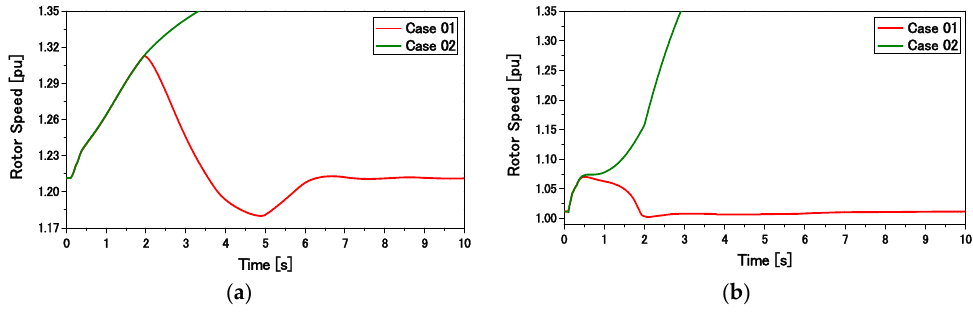
Figure 19. Rotor speed response of wind generators: ( a ) DFIG; ( b ) SCIG.